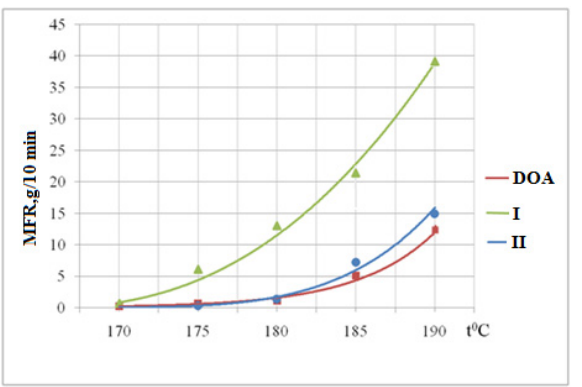
Figure 12. Dependence of the MFR of the PVC composition on temperature. I–II—Symbols of plasticizers (Table 1).